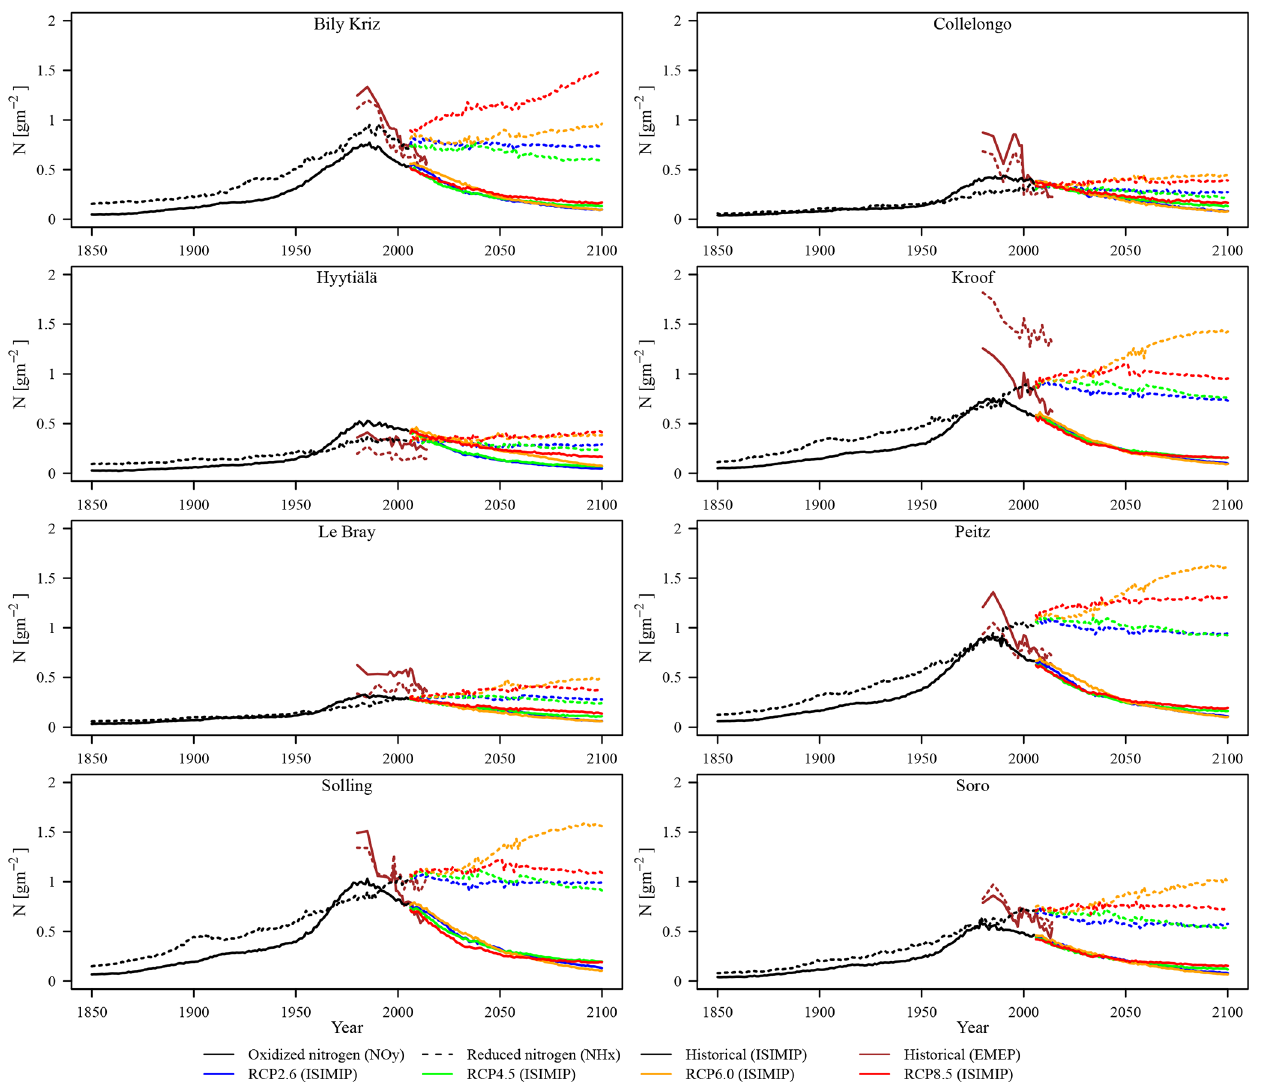
Figure 5. Total deposition of reduced (NH x ) and oxidized (NO y ) nitrogen (N) at each of the sites of the PROFOUND DB. The historical period for the EMEP data extends from 1980 to 2014 and for the historical ISIMIP data from 1861–2005. The future scenarios are available from 2006 to 2100 and follow the RCP2.6 and RCP6.0 scenarios. Please note that the two Solling sites have the same N depositions (see text for further